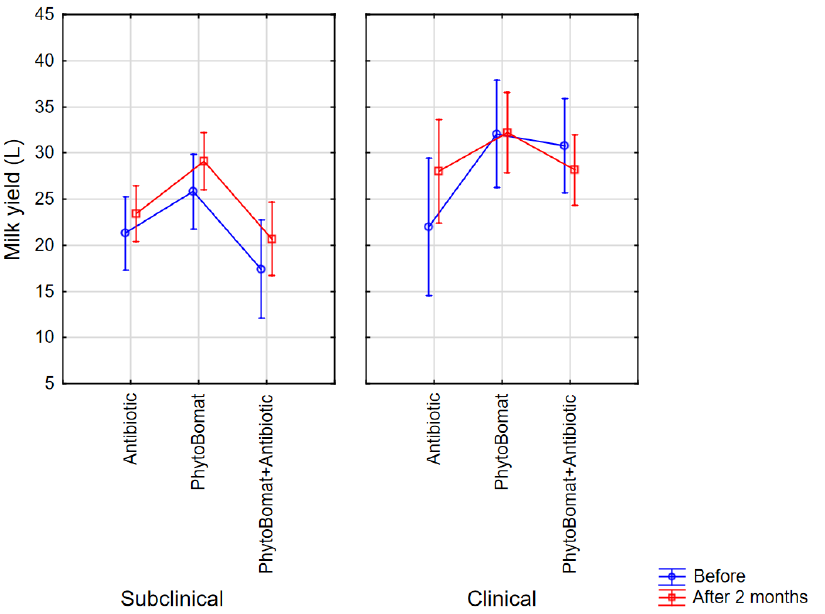
Figure 1. Daily milk yield before and 2 months after the completion of different treatments (antibiotics, Phyto-Bomat and Phyto-Bomat + antibiotic). Vertical bars denote 0.95 confidence interval.